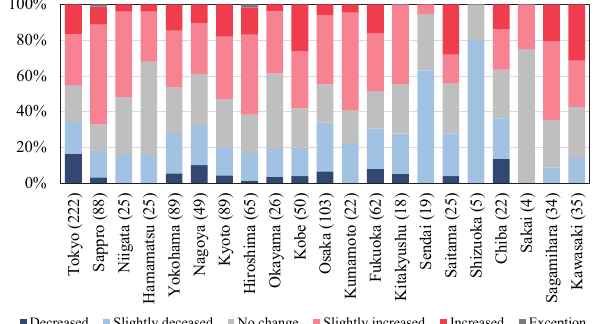
Table 2 summarizes the human mobility change patterns according to the time slots. The five clusters were classified into three patterns: decreased (C1, C2), no change(C3), and increased type (C4, C5). Also, ~40% of grids were classified as the increased type, and 23% of grids were classified as the decreased type for all the time slots. Although the change patterns fluctuated according to the time slot, we identified few contrasting patterns between time slots, such as the increased type in the morning and decreased pattern in the afternoon. Figure 9 illustrates the proportion of clusters according to cities with the focus on grids with more visitors than residents during the daytime. The proportion varied from city to city, but most cities experienced both increased and decreased patterns. Several cities with small populations within, such as Niigata, Hamamatsu, Figure 9 . Proportion of change pattern by cities and Sakai, did not reveal C1, thereby indicating a significant